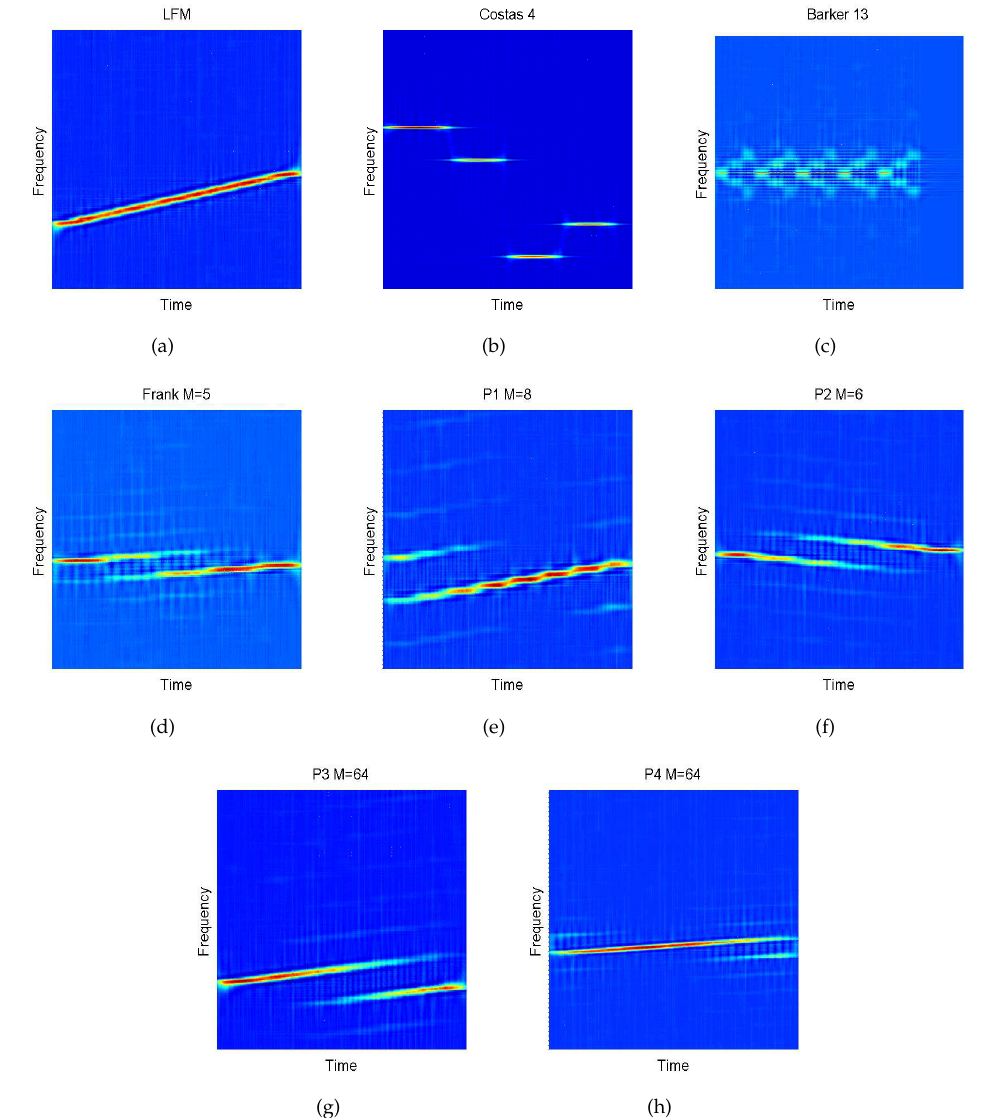
Figure 4. In this figure, ( a )–( h ) are different waveform classes, which including Linear frequency modulation (LFM), Costas codes, Binary phase shift keying (BPSK), Frank, P1, P2, P3 and P4 sequentially. There are significant differences among the Choi–Williams time-frequency distribution (CWD) images. The controllable factor σ = 1 also be